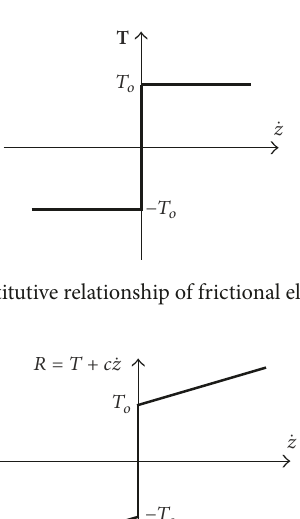
Equation (3) is a linear relation between 𝑅 and 𝑢 fl 𝑦−𝑥 .